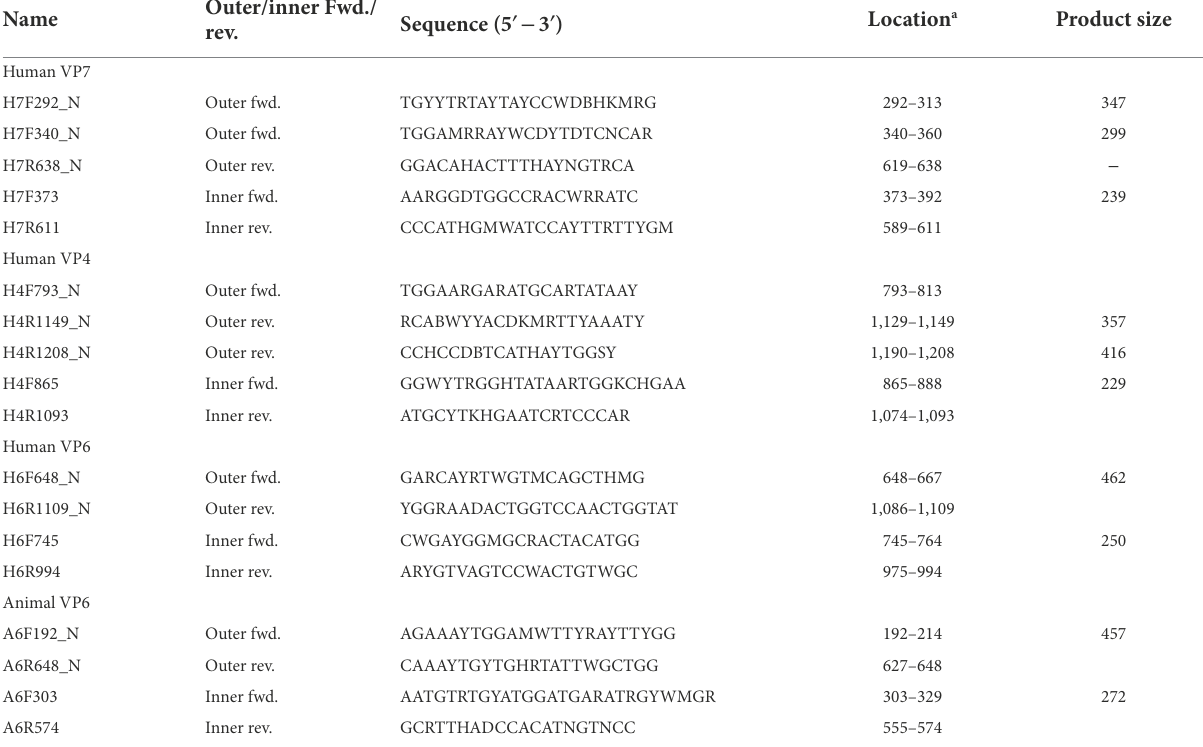
TABLE 1 Oligonucleotide primers specific to VP7, VP4, and VP6 RVA